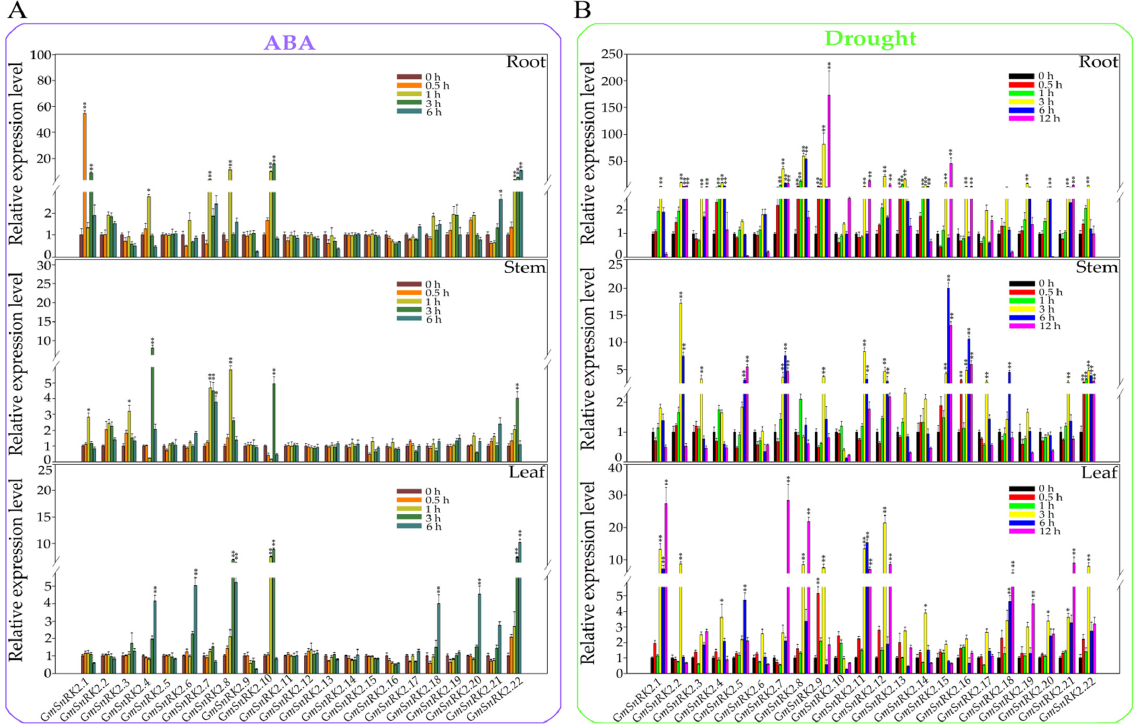
Figure 9. Expression analysis of GmSnRK2s under ABA and drought treatments. ( A ) Expression analysis of the GmSnRK2s in the roots, stems and leaves of soybean under ABA treatment. ( B ) Expression analysis of the GmSnRK2s in the roots, stems and leaves of soybean under drought treatment. The expression levels in roots, stems and leaves before treatment (0 h) were used as controls and were assigned a value of 1. GmSKIP was used as an internal reference. Each point represents the mean value ± SE of three independent experiments performed in triplicate. The differences were statisti- cally assessed using Student’s t test (**, p < 0.01; *, p < 0.05). The error bars in A and B represent the SEs of three